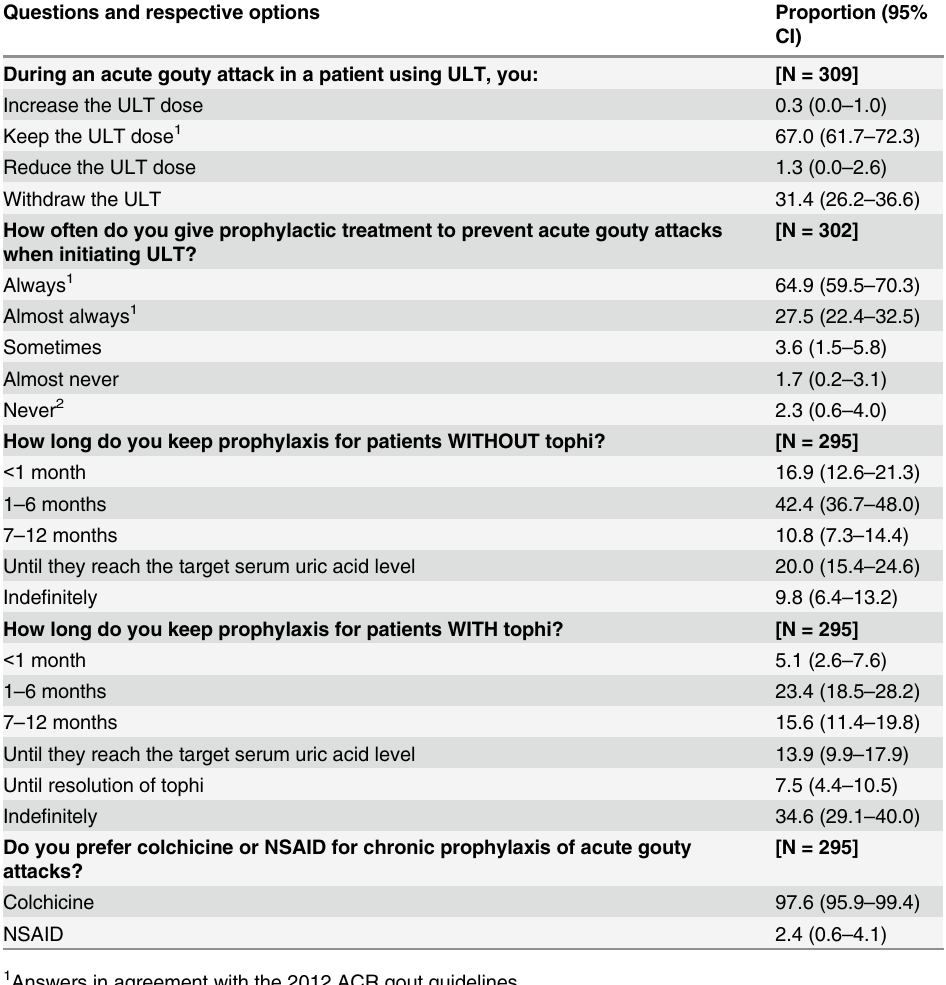
Table 3. Management of urate-lowering therapy (ULT) during an acute gouty attack and anti-inflamma- tory prophylaxis of gout attacks. Questions and respective